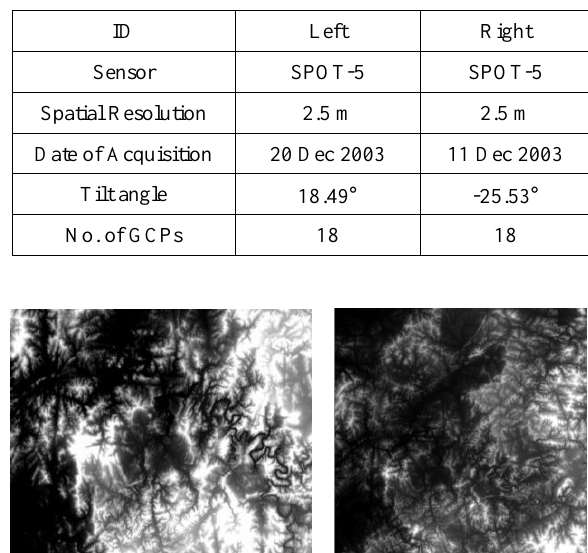
Table 1. The properties of the SPOT-5 stereo pair used.